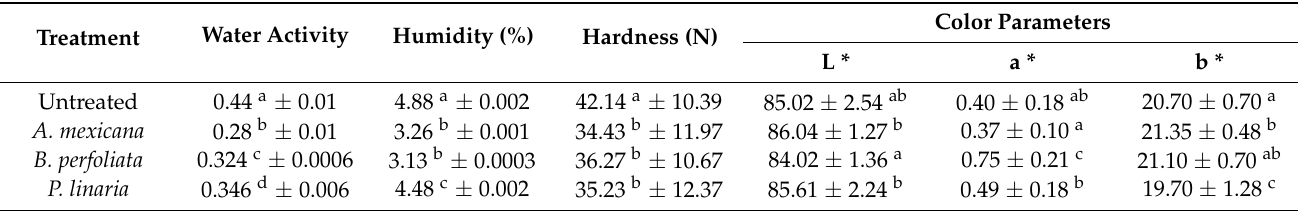
Table 8. Water activity, humidity, hardness, and color parameters (L *, a *, b *) of cookies elaborated with flour from wheat treated with the essential